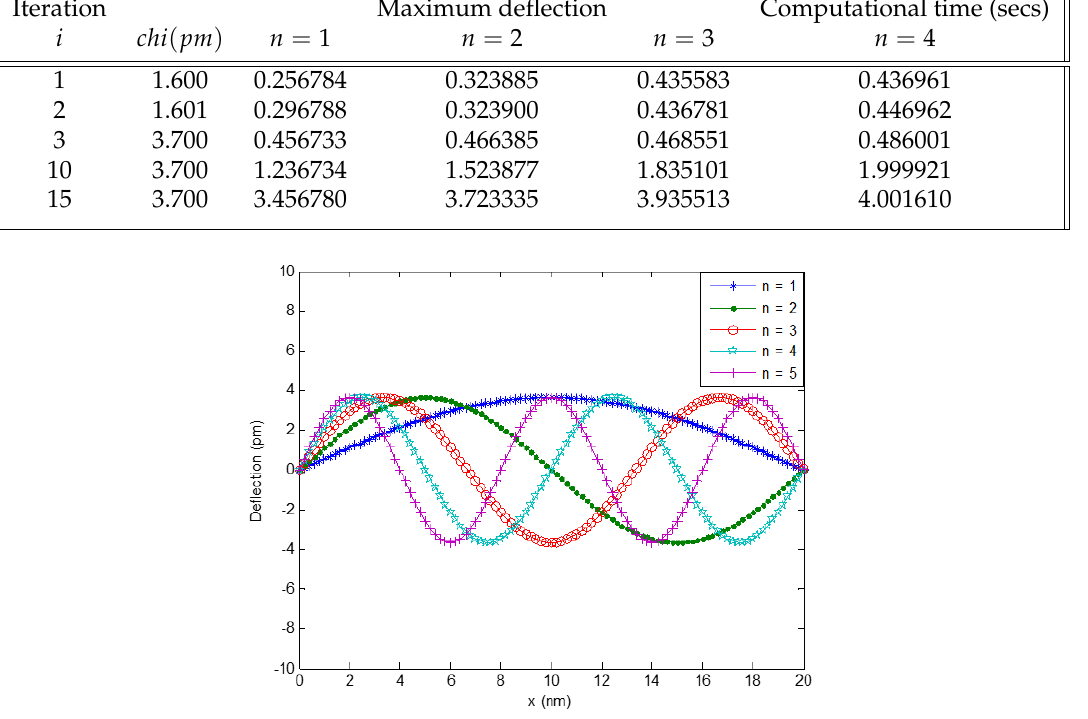
Figure 3. SWCNT modes with pinned-pinned